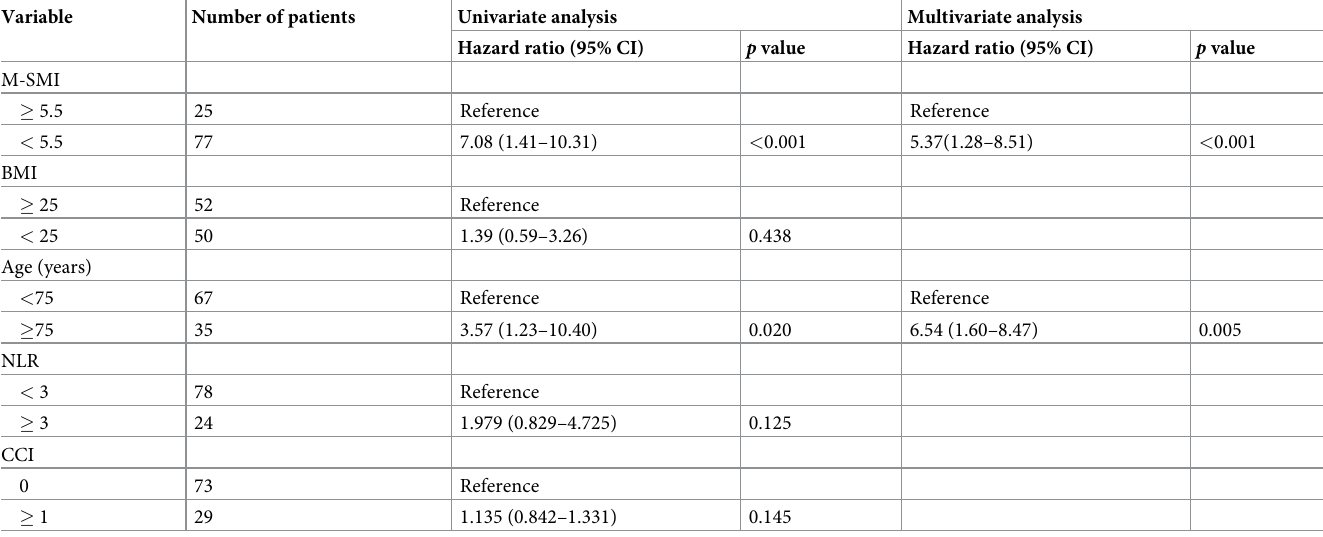
Table 5. Cox logistic regression analysis of independent predictors of